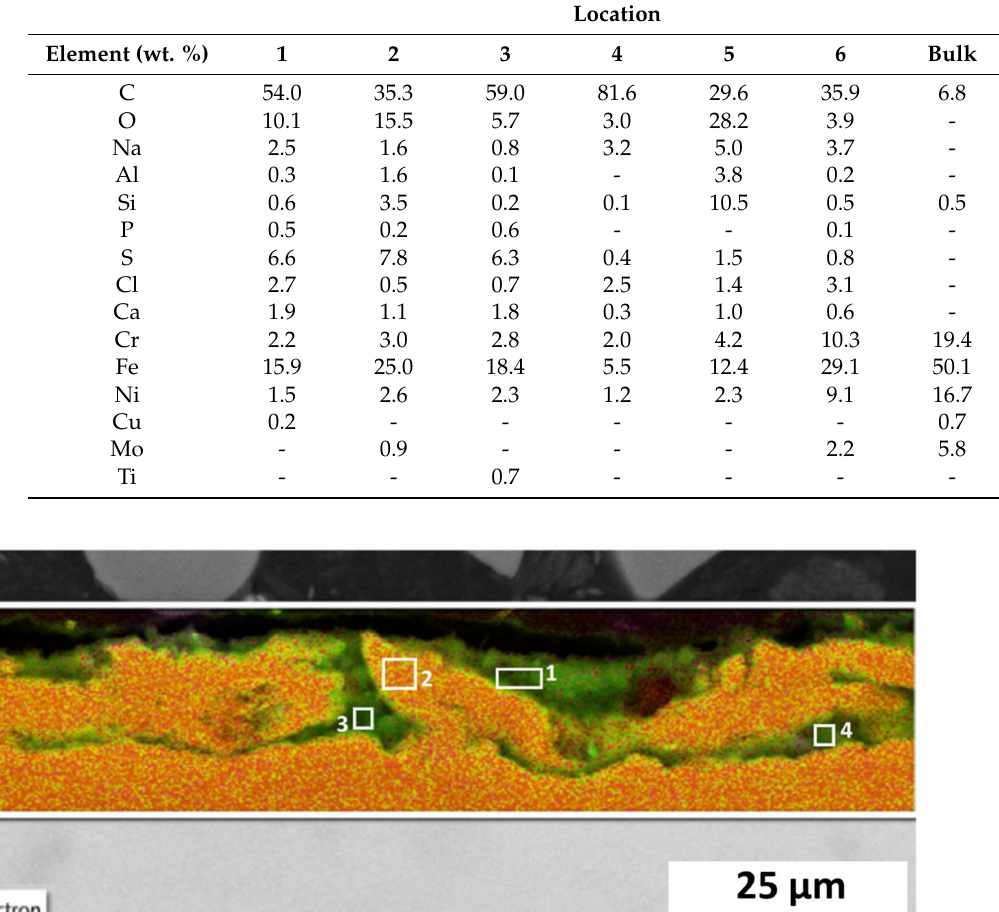
Table 11. EDX elemental analysis of locations shown in Figure 17. For comparison, an analysis of the bulk material after exposure at Chaunoy is included.